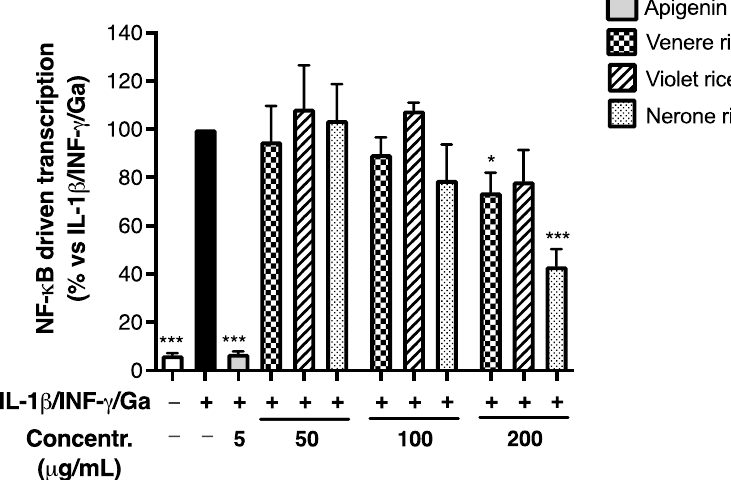
Figure 4. Effect of black rice extracts on NF- κ B-driven transcription. Caco-2 cells were stimulated by IL-1 β (10 ng/mL), IFN- γ (10 ng/mL), and in vitro digested gliadin (Ga) (1 mg/mL) for 6 h. Unstimulated condition was also reported (white bar, Control − ). The NF- κ B-driven transcription was measured by luciferase assay and expressed as mean emission ± SEM vs. stimulus (black bar, Control +), to which was arbitrarily attributed the value of 100%. * p < 0.05, *** p < 0.001 vs.